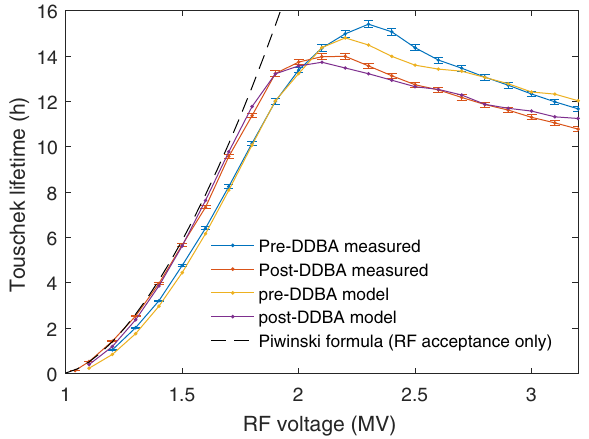
FIG. 8. Comparison of Touschek lifetime vs rf voltage for the bare lattice. Measured data is compared to the results from particle tracking and analytic calculations, both before and after installation. The error bars for the measured data are estimates based on fluctuations observed during data